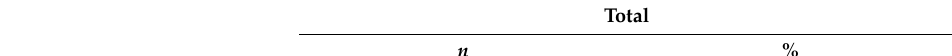
Table 7. Public confidence in the government. a Number for each item may not add up to a total number of study population due to missing